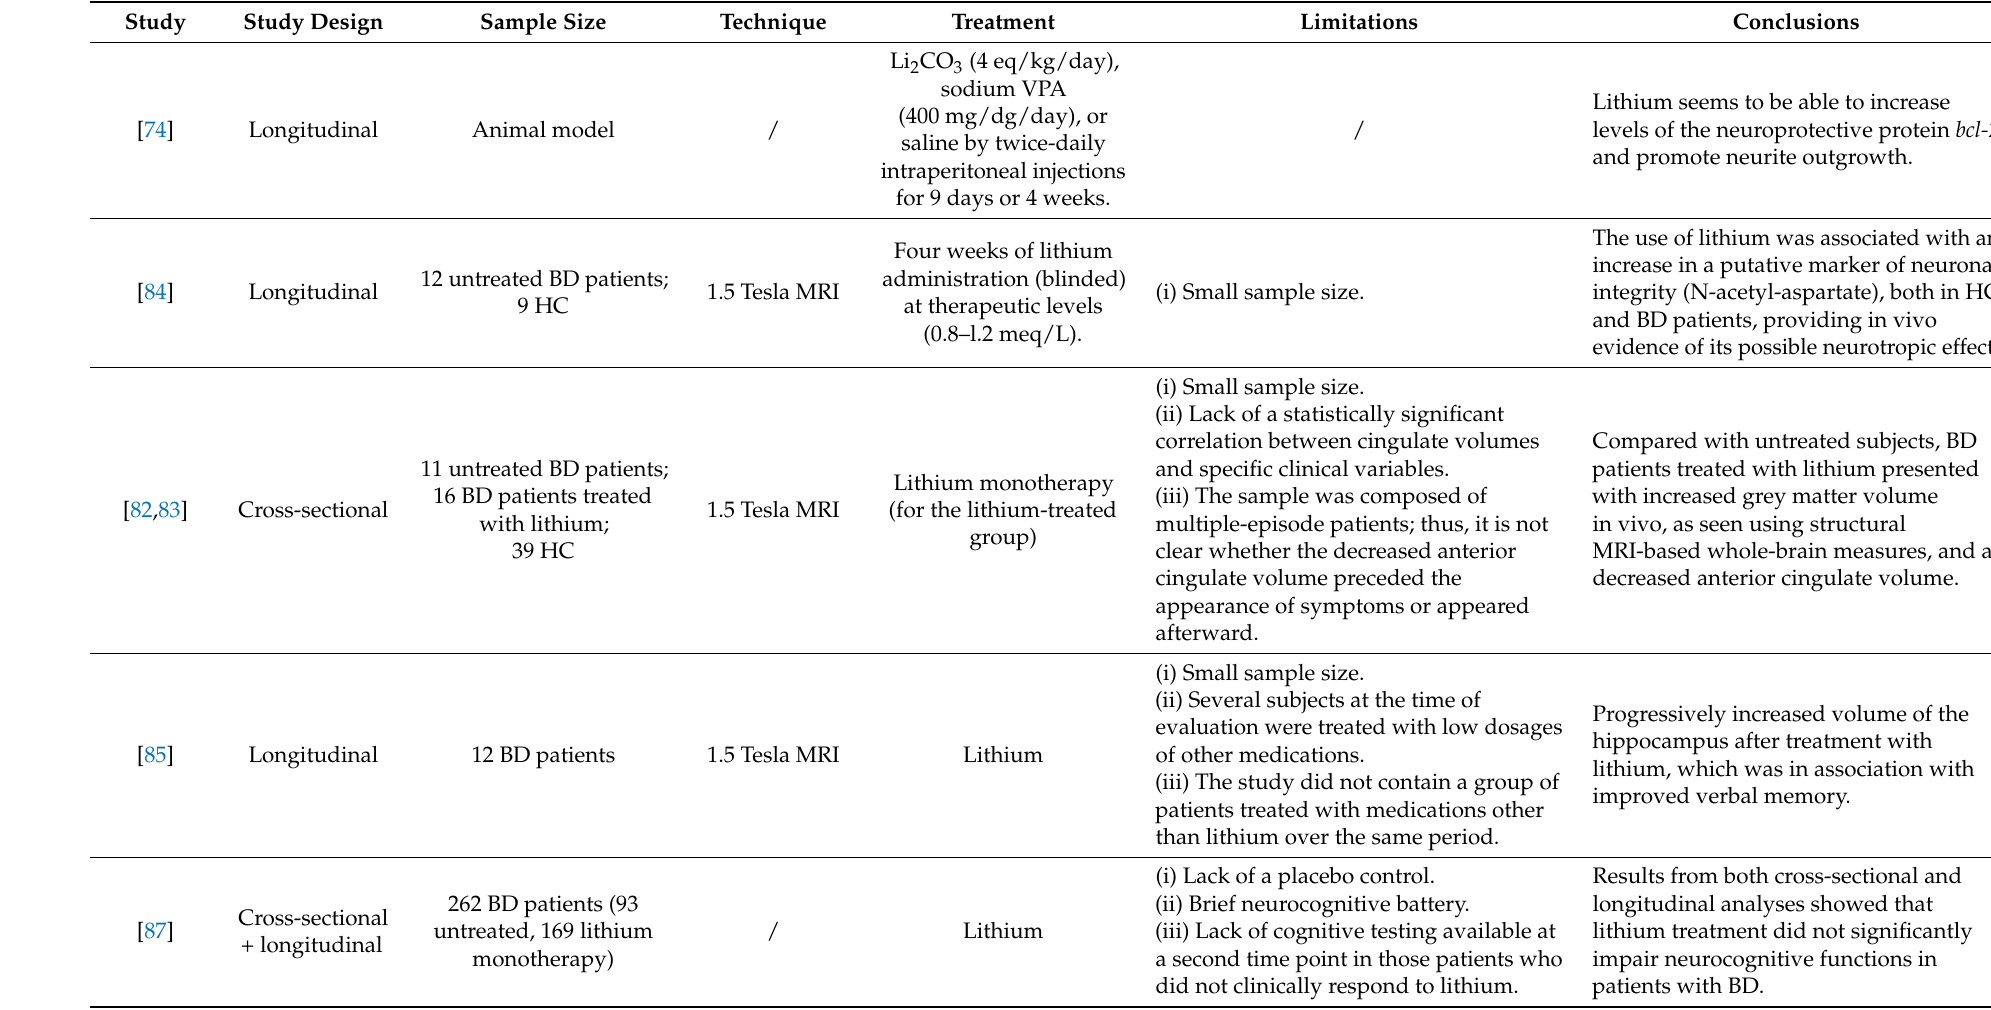
Table 3. BD and neurodegeneration: the role of pharmacological available